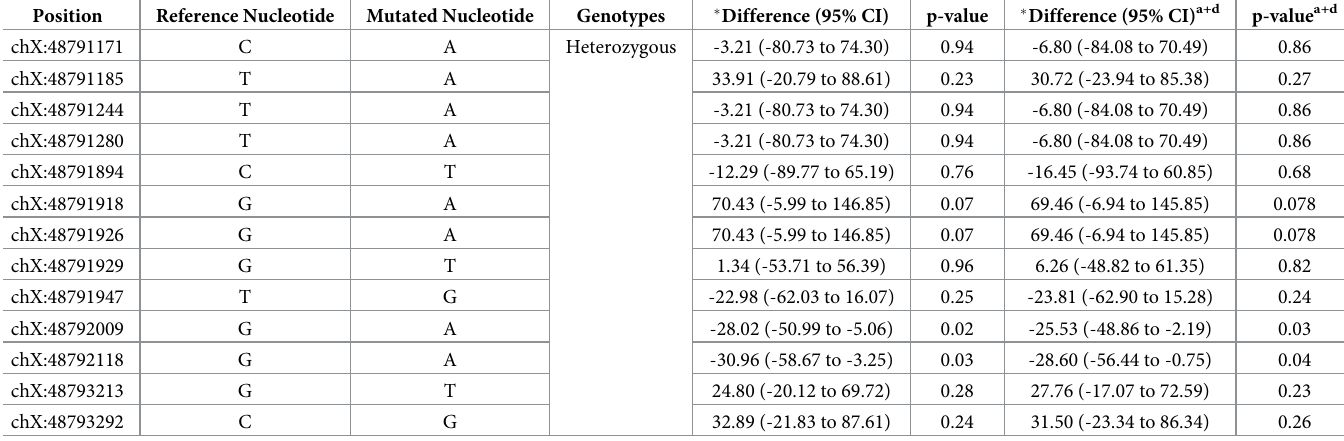
� Difference = mean platelet counts with respect to heterozygous mutant–mean platelets count with respect to wild type a+d = after adjusting age and dengue fever type (DF and